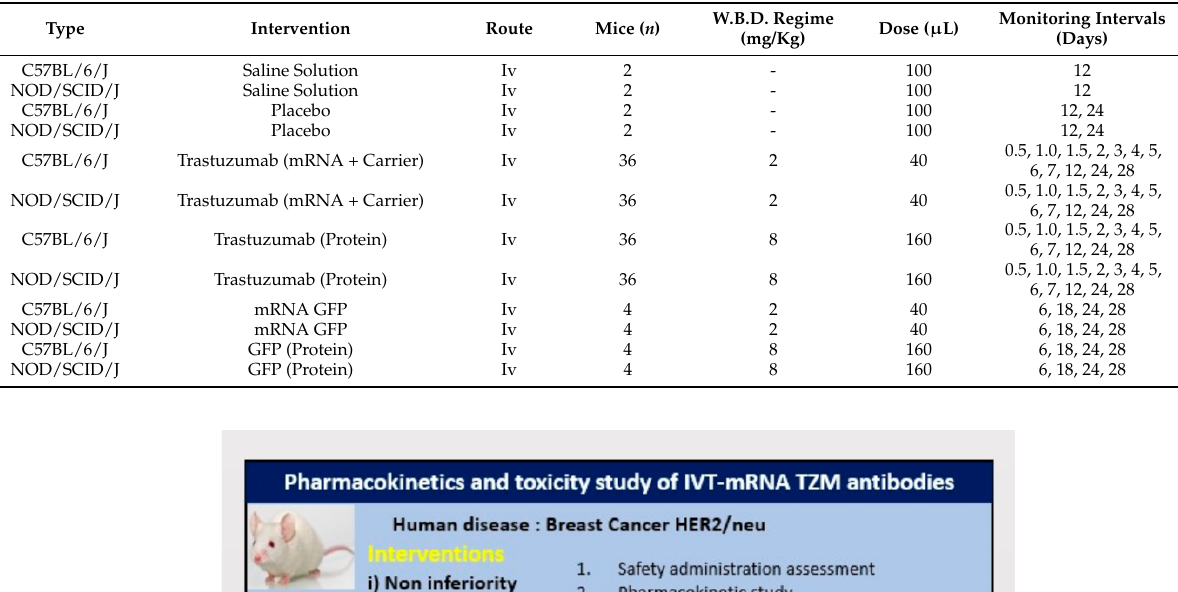
Table 1. Intervention schedule for each animal type according to dose regime and substance administrated for the time monitoring checkpoints.